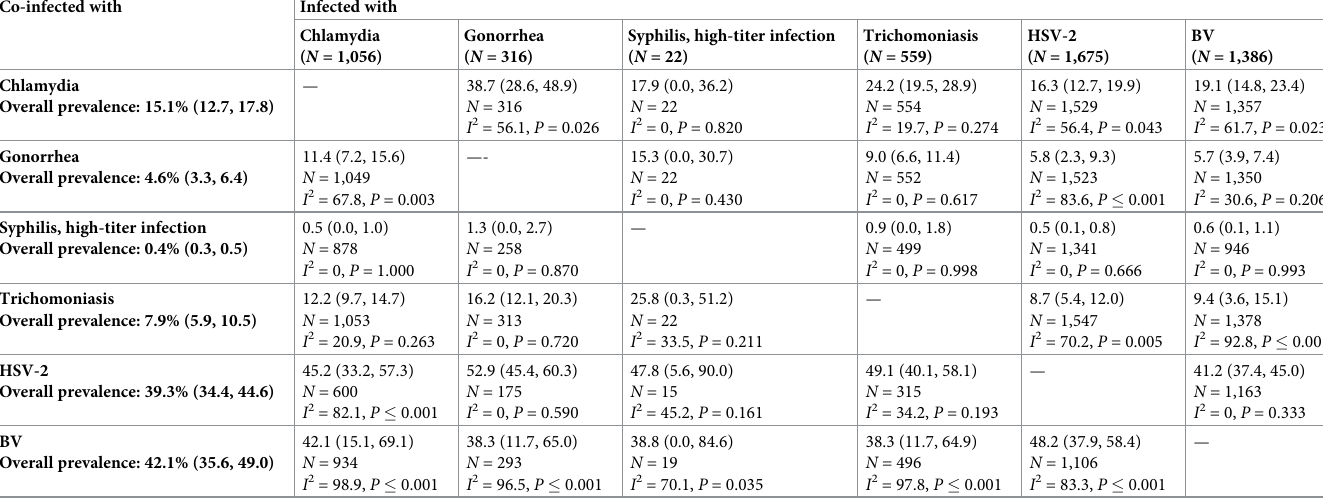
Table 5. Proportion of participants with each infection who are co-infected with an additional STI or BV among women aged 25–49 years in South African clinic/ community populations. Co-infected with Infected with Chlamydia Overall prevalence: 7.0% (5.5, 8.8) Gonorrhea Overall prevalence: 2.5% (1.6, 4.0) Syphilis, high-titer infection Overall prevalence: 1.0% (0.5, 2.1) Trichomoniasis Overall prevalence: 8.6% (6.5, 11.5) HSV-2 Overall prevalence: 77.8% (75.6, 79.9)